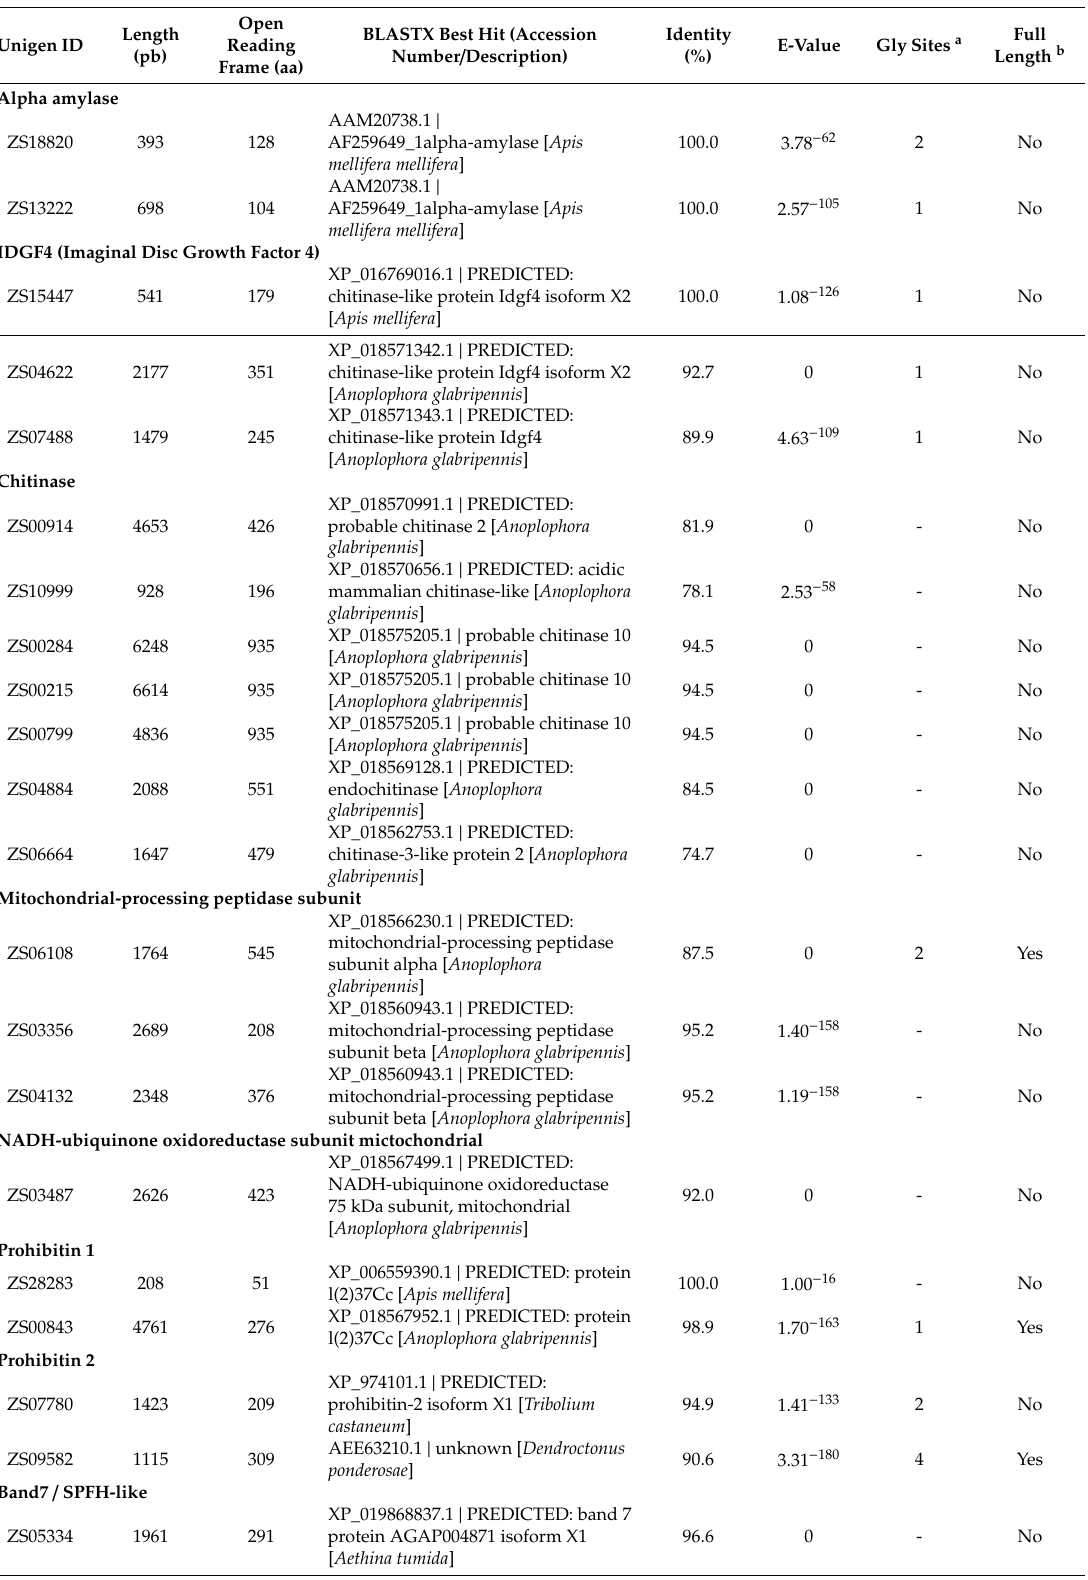
Table 3. Unigenes encoding to putative lectin PF2 targets of Z. subfasciatus